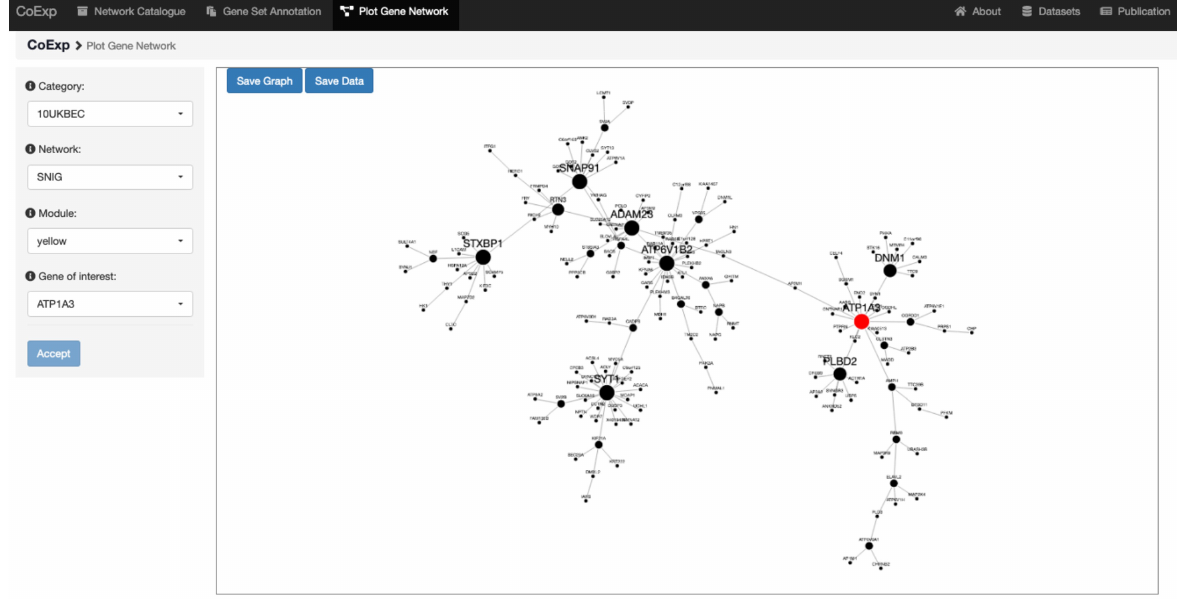
FIGURE 6 | Use of the Plot Gene Network Tab. This figure shows the view we get when we use the Plot Gene Network tab to visualize the gene ATP1A3 . We chose this gene because it is associated with PD and is one of the genes with high module membership within the yellow module of the SNIG GCN within the 10UKBEC category ( Figure 5 ). After clicking the “Accept” button, the plot shows, highlighted in red, the gene ATP1A3 as a very important gene within its module (as indicated by the large node size). There are 16 other genes, which appear as its nearest neighbour and they can be used to further study the transcriptomic context of ATP1A3 . Note that this example has been visually recreated in a demonstration video available at the Help section of the CoExp web under the “Plot Gene Network”